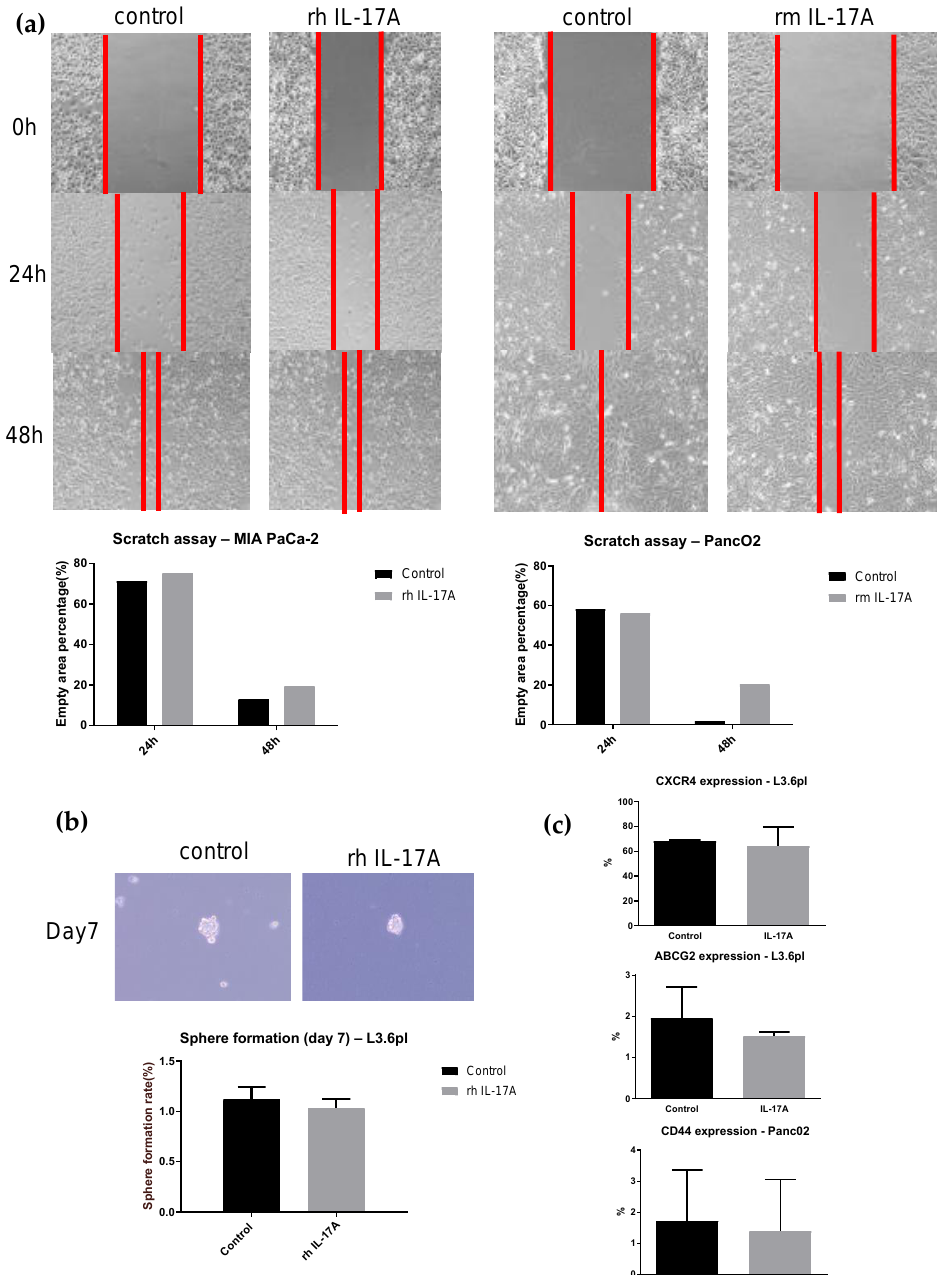
Figure 2. IL-17A does not induce cancer stem cell features in human or mouse PDAC cells in vitro . ( a ) Wound healing assay in pancreatic cancer cell lines. MIA PaCa-2 and Panc02 were treated 48 h with 20 ng/mL recombinant IL-17A or PBS. The wound area was assessed 24 and 48 h after scratching. The boundary of cancer cell migration is marked with red lines. ( b ) Sphere formation assay using human L3.6pl cells treated with 20 ng/mL recombinant human IL-17A or PBS for 48 h. Sphere formation rate at day 7 was calculated as the sphere number divided by the initial cell number plated and expressed as a percentage (Mean ± SEM). ( c ) Detection of human pancreatic stem cell markers ABCG2 and CXCR4 using flow cytometry in human pancreatic L3.6pl cells treated with 20 ng/mL recombinant human IL-17A or PBS for 48 h. CD44 was assessed in the pancreatic mouse cell line Panc02 under the same experimental